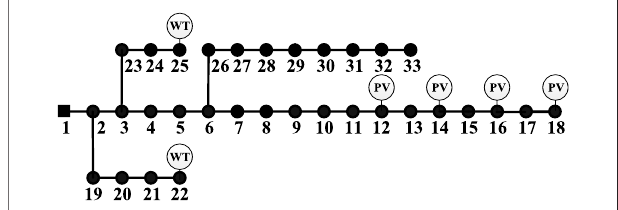
FIGURE 6 | Structure of the modi fi ed IEEE 33-node